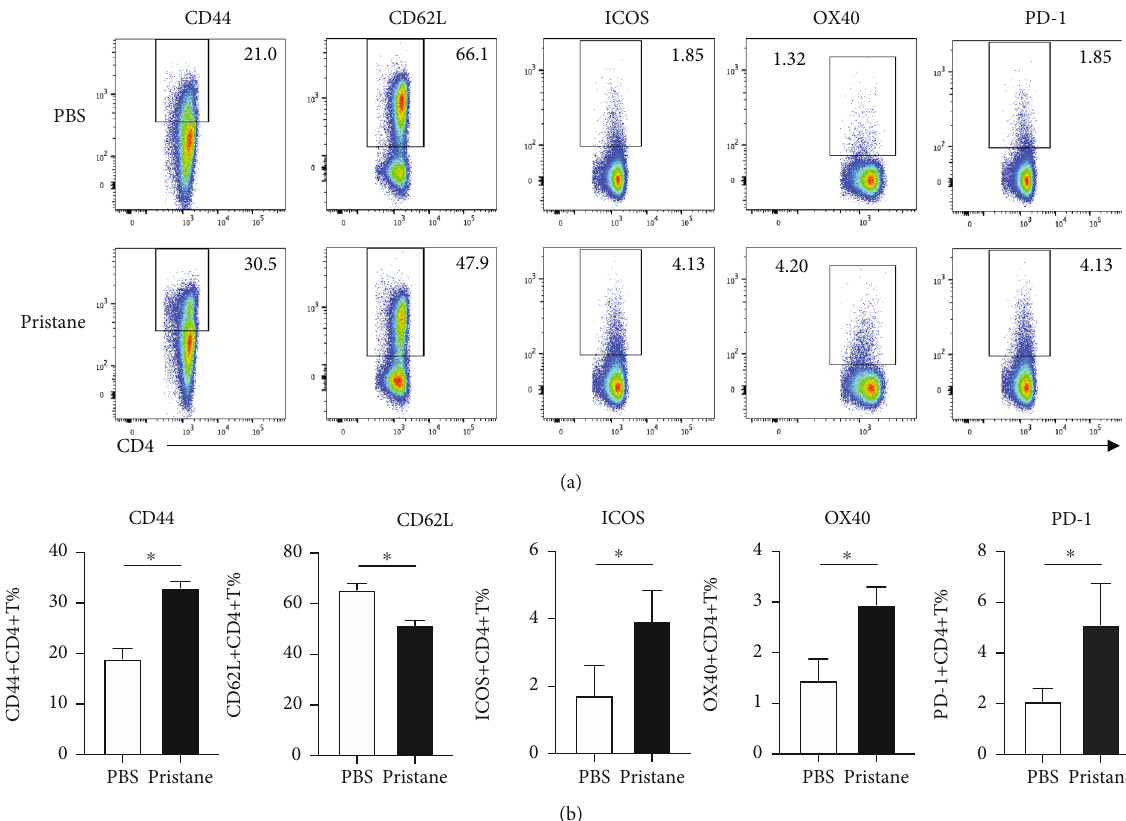
Figure 2: Activated phenotypes of CD4 + T cells in the pristane-induced lupus-like mouse model. The splenocytes were collected at 6 months after i.p. injection of PBS or pristane. (a) The expression levels of CD62L, CD44, ICOS, OX40, and PD-1 on CD4 + T cells. (b) Statistic percentages of CD62L, CD44, ICOS, OX40, and PD-1 on CD4 + T cells in the spleens of PBS or pristane-treated mice. ∗ p < 0 : 05